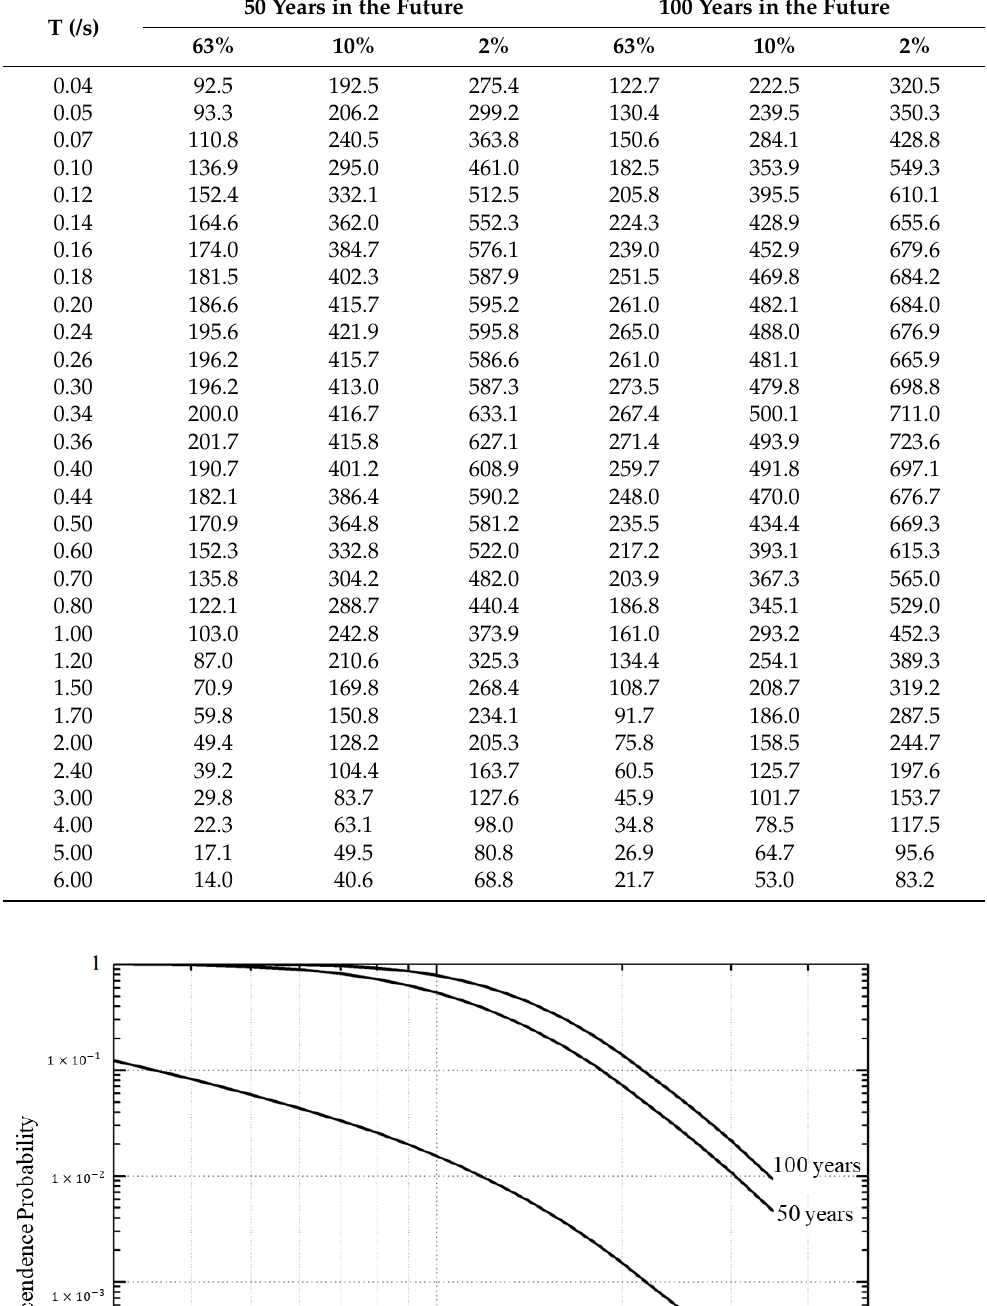
Table 7. Response spectrum values of the bedrock horizontal acceleration at the engineering site (cm/s 2 ).